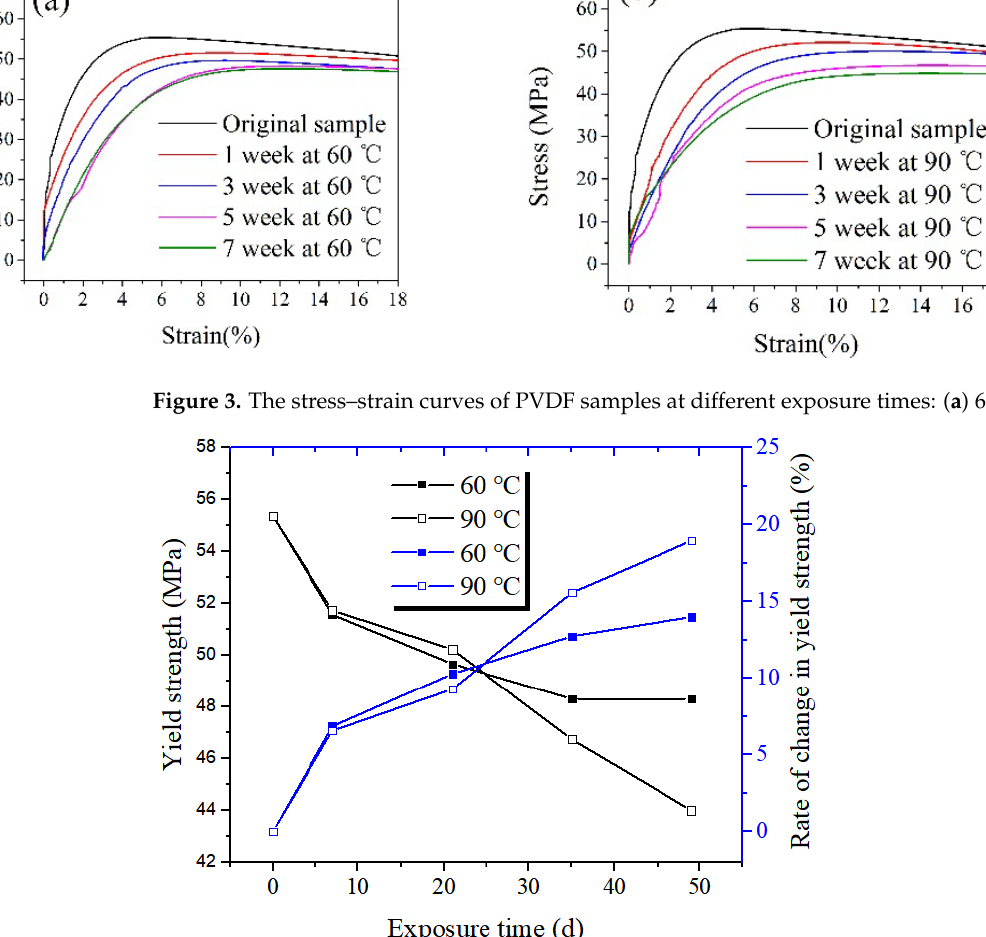
Figure 4. Yield strength and its change rate of PVDF samples at different exposure times.